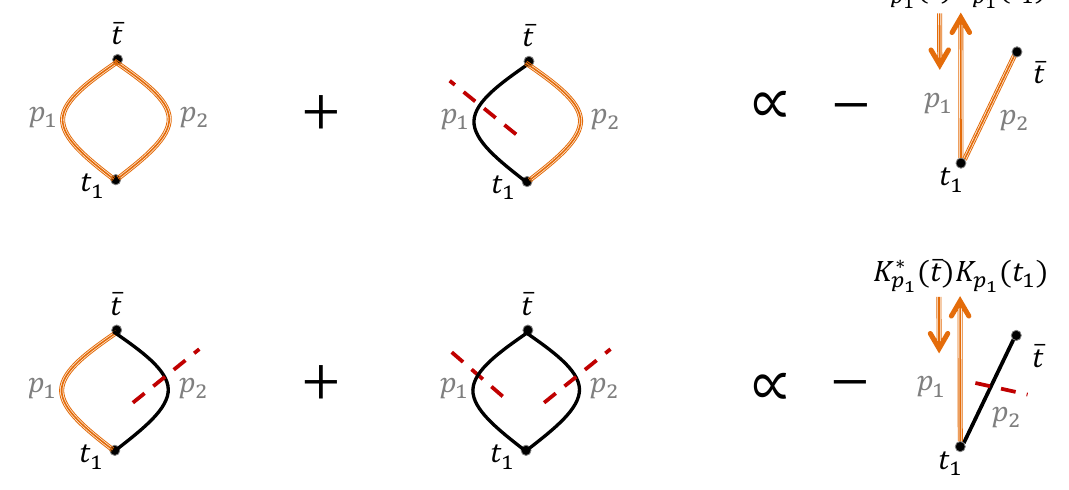
Figure 5 . Diagrammatic representation of (4.13) and (4.14), showing the pairwise sum of two loop diagrams that differ only by the cut of a single line. The two terms on the right-hand-sides exactly